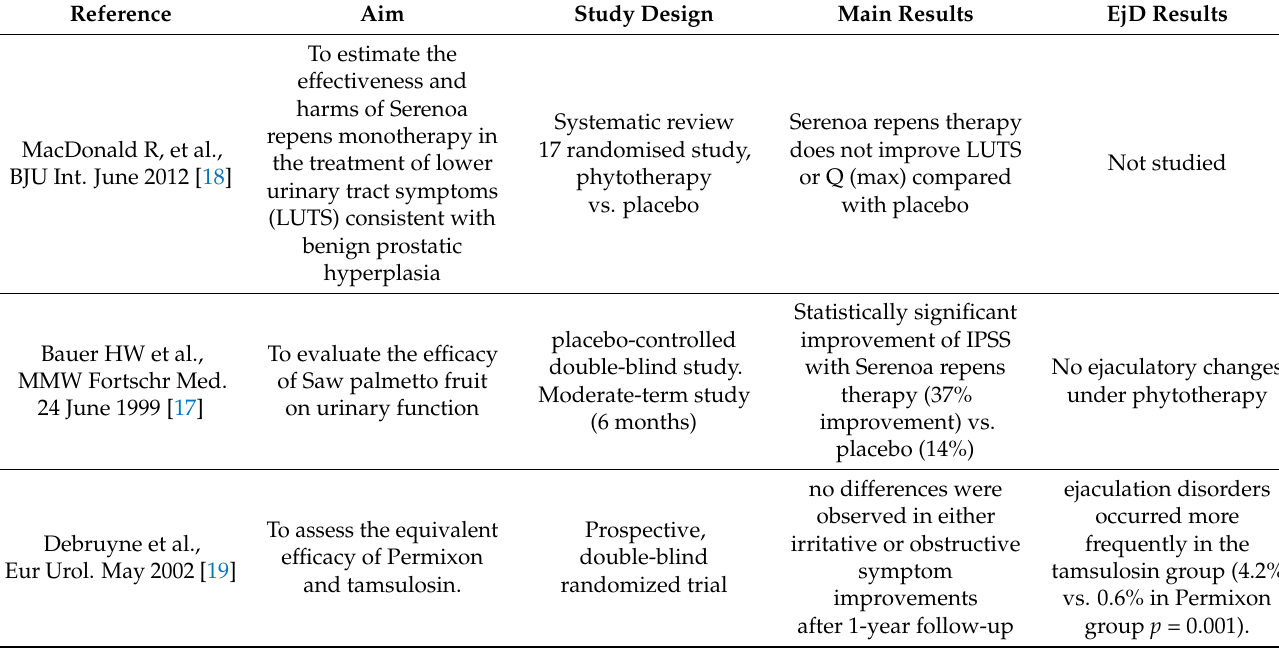
Table 1. Impact of phytotherapy on ejaculatory